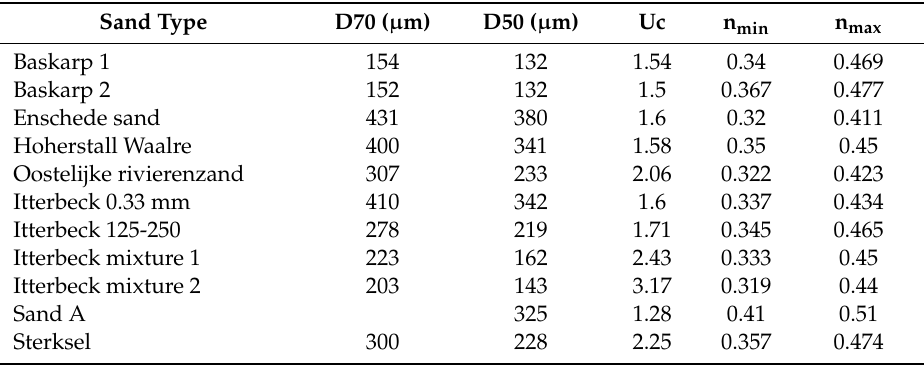
Table A2. Properties of the sands used. D50 and D70 are the diameters of the 50 and 70 percent weight fractions respectively. Uc is the uniformity coe ffi cient and n min and n max are the minimum and maximum wet porosities